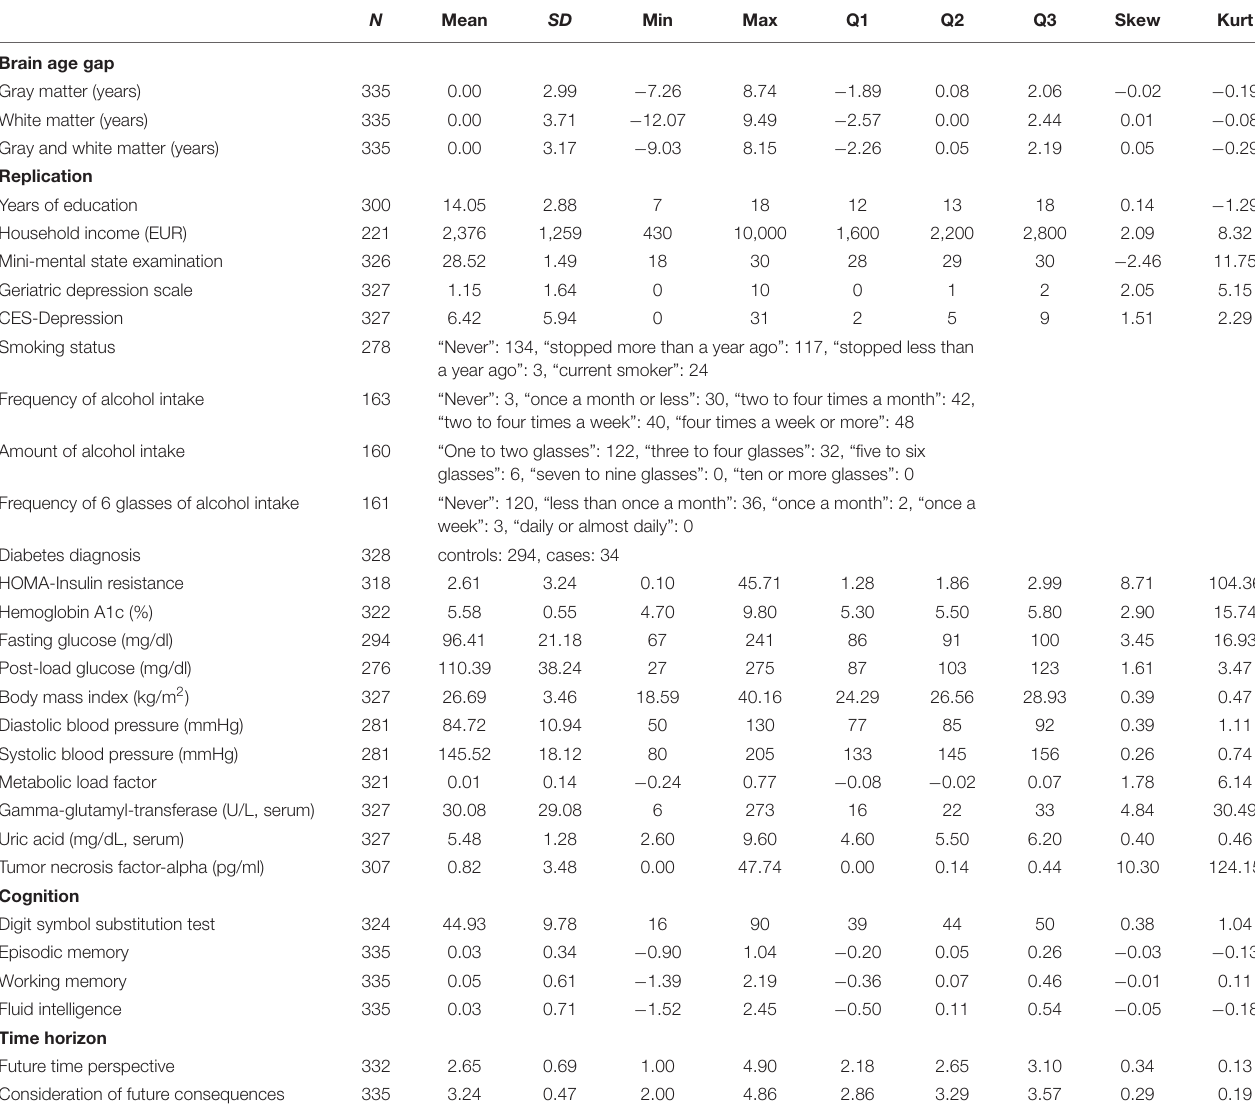
TABLE 1 | Descriptive statistics of the three brain age gap and 27 criterion